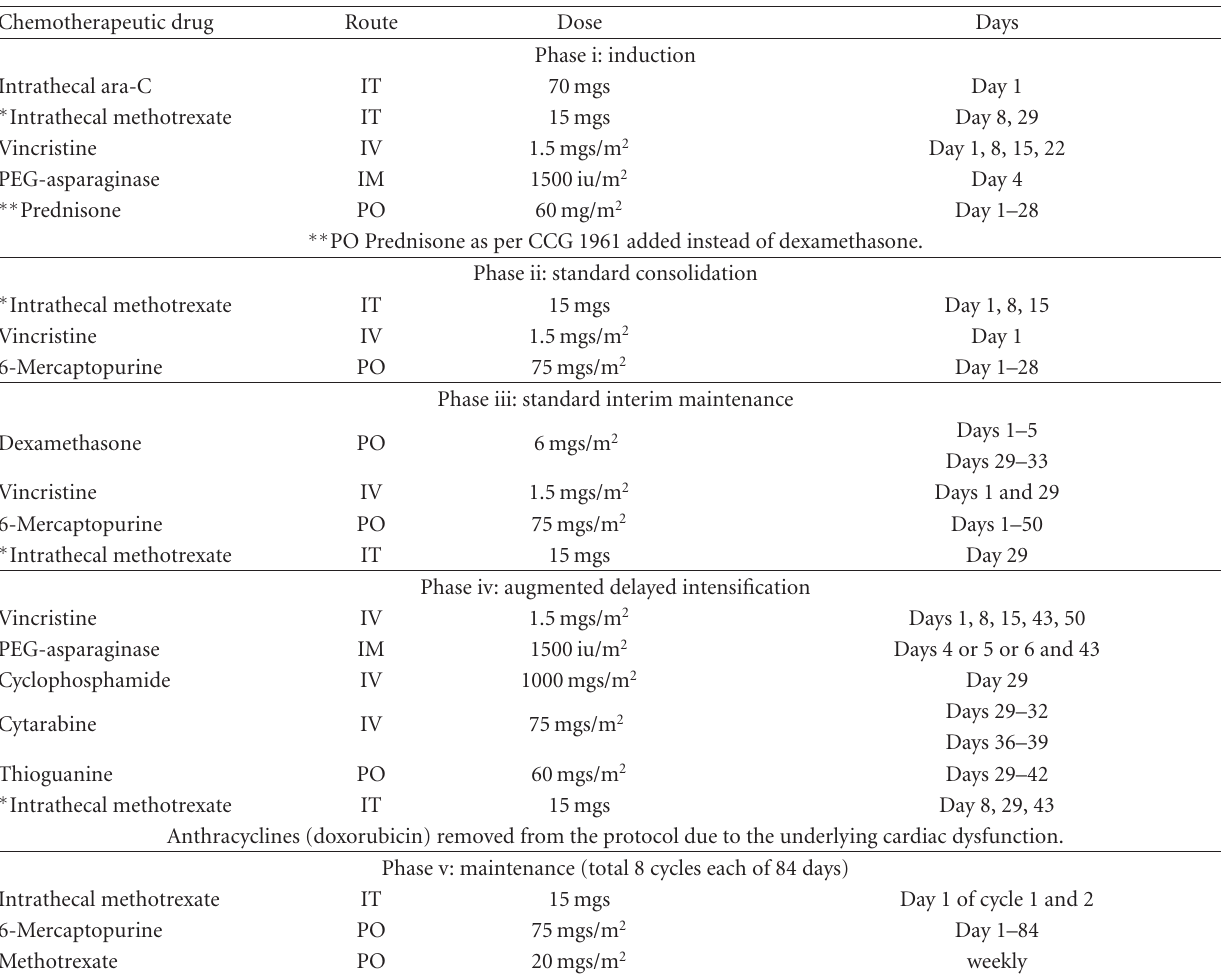
Table 1: Modified chemotherapy regimen used for our subject using the standard-risk ALL0331 backbone with modifications. Chemotherapeutic drug Route